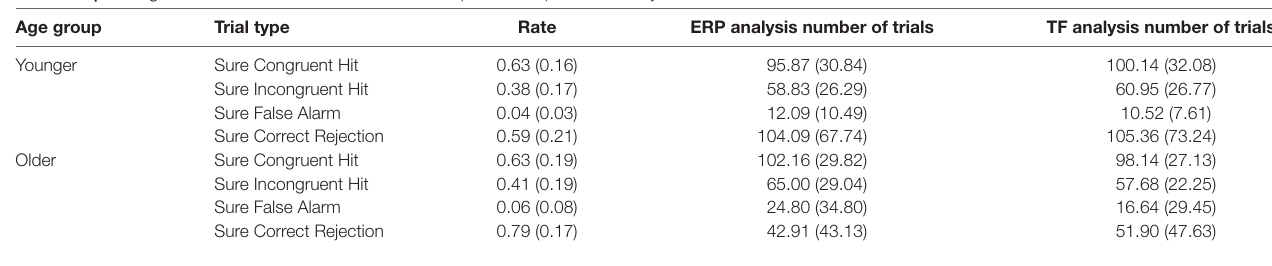
TABLE 2 | Average trial numbers and standard deviations (in brackets) for EEG Analyses. Age